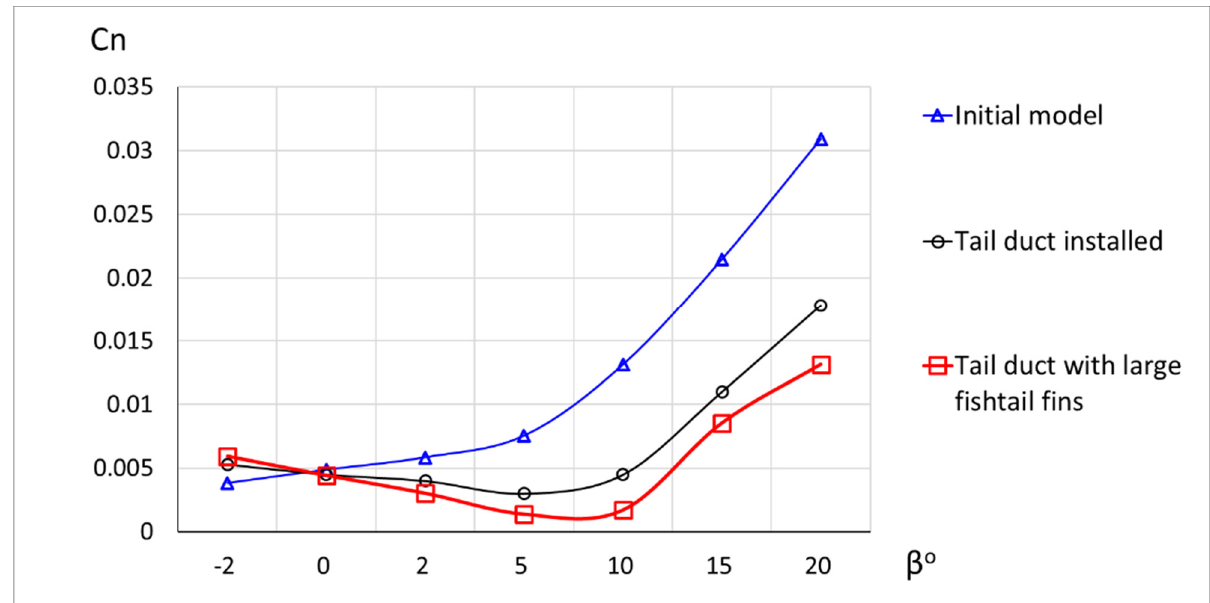
Figure 25. Yaw moment coefficient of the initial model without any additional elements against the model equipped with a tail duct and tail duct supplied with large vertical fins. model equipped with a tail duct and tail duct supplied with large vertical